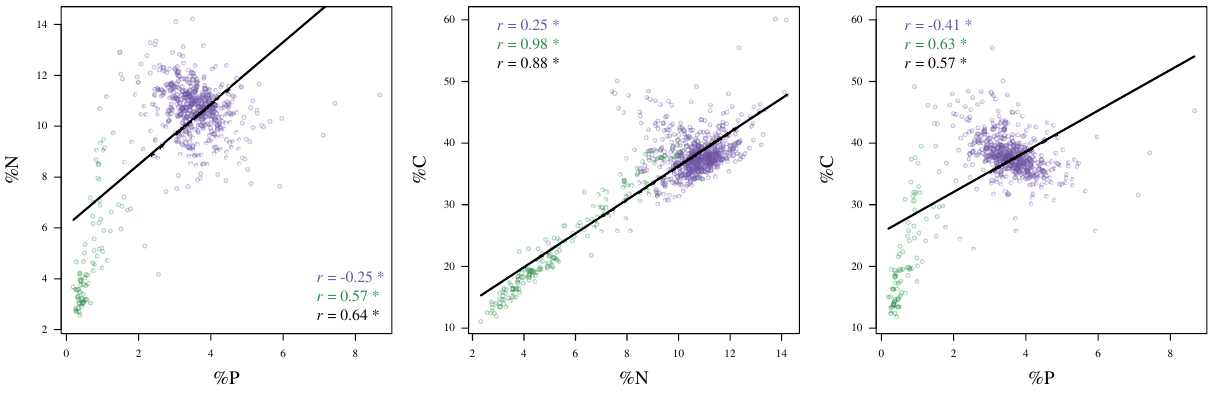
Figure 4. Correlations of stoichiometric relationships between elements. Colors indicate datasets: green = invertebrates only, purple = vertebrates only, black = full dataset. Text in each plot indicates the correlation, * = significant at alpha < 0.05. Dashed black line indicates a slope of 1 for